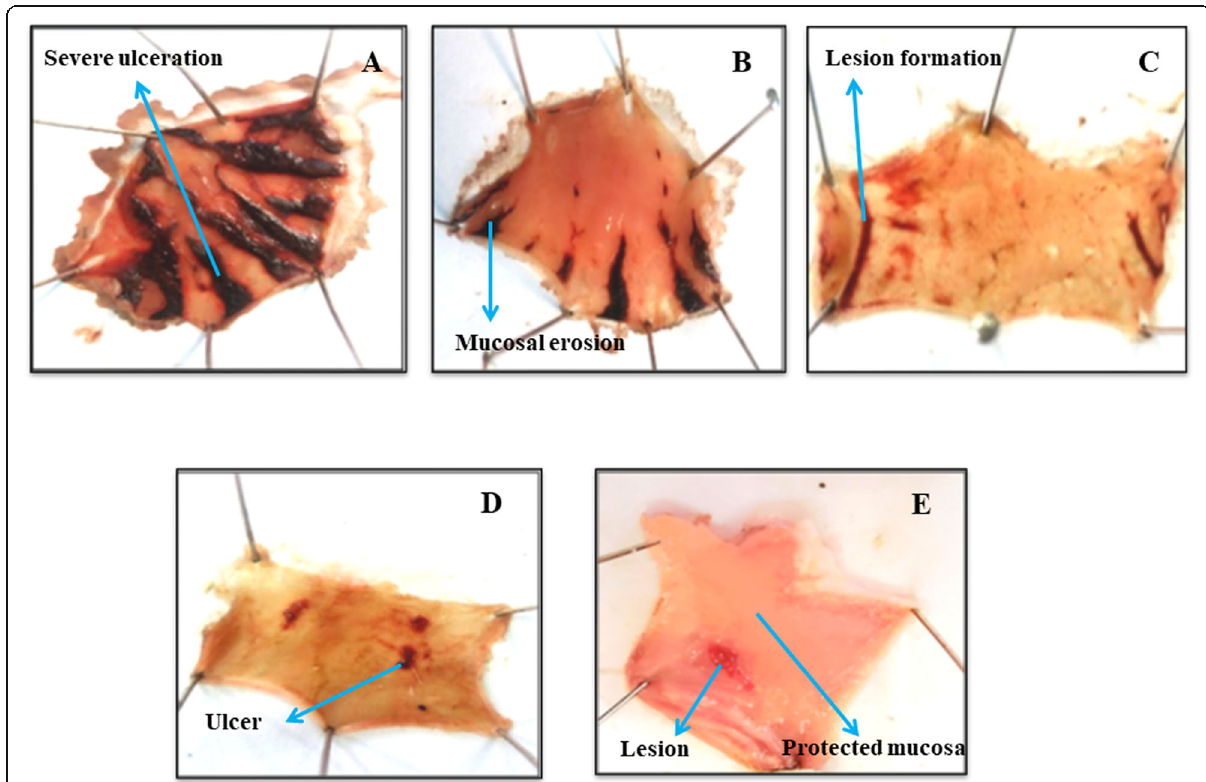
Fig. 5 Gross-appearance of gastric mucosa in rat: ( a ) pre-treated with saline, 10 mL/kg (ulcer control). Severe injuries are seen, as ethanol-HCl (1